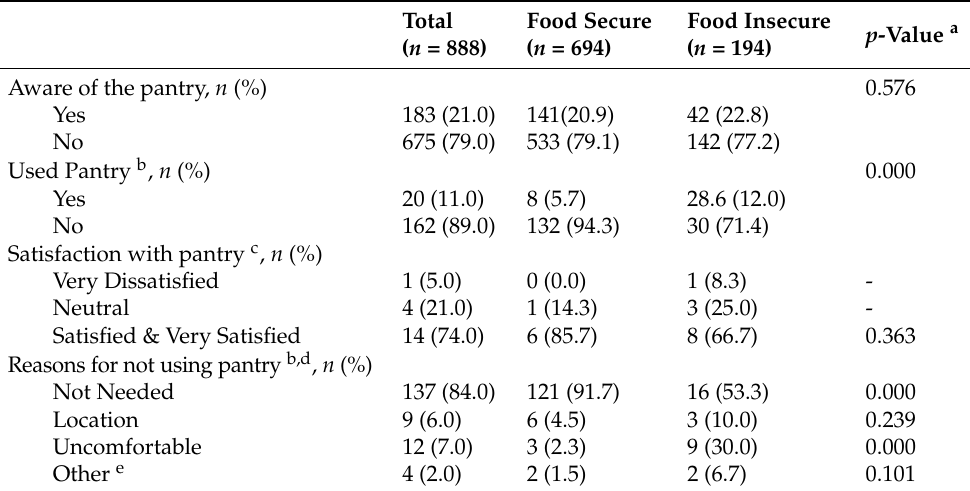
Table 2. Prevalence of awareness, use, satisfaction, and barriers to using the campus food pantry by food security status among college students from a campus survey conducted in March 2021 ( n = 888).